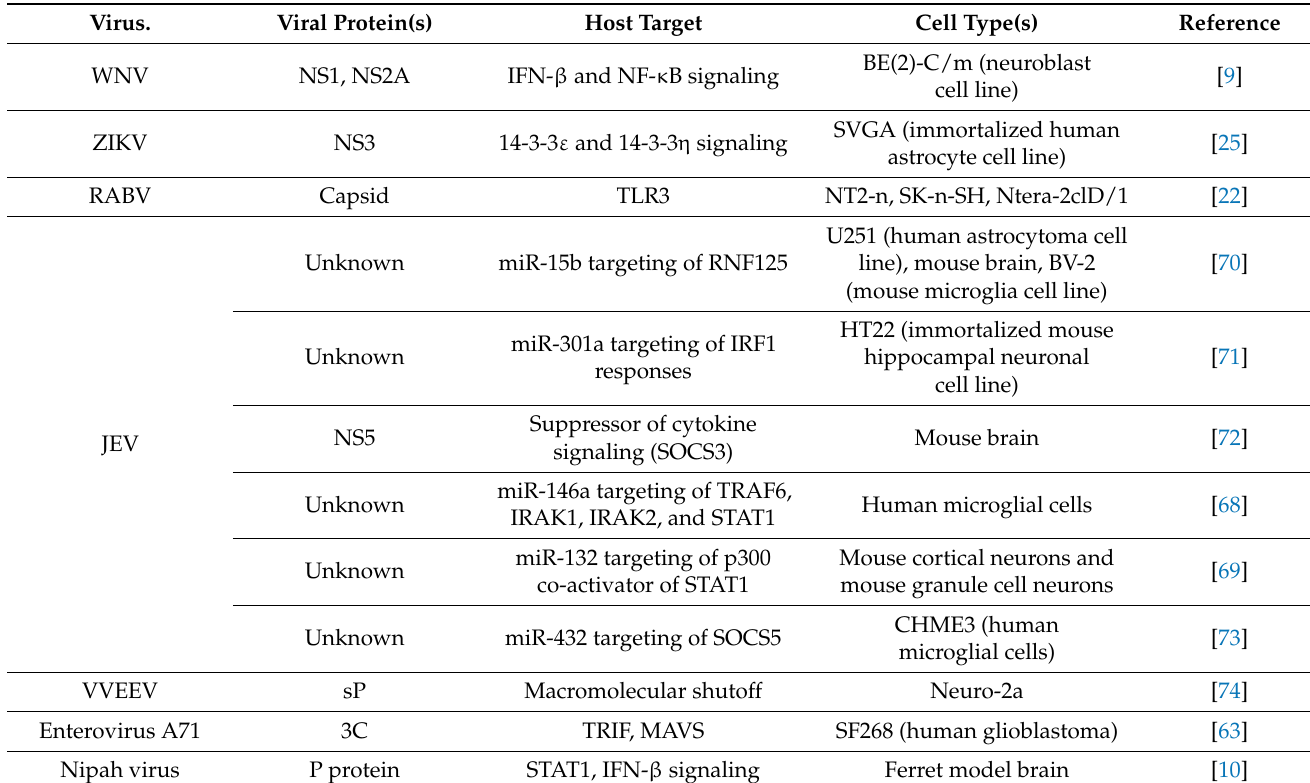
Table 2. Viral protein host targets for immune antagonism in the